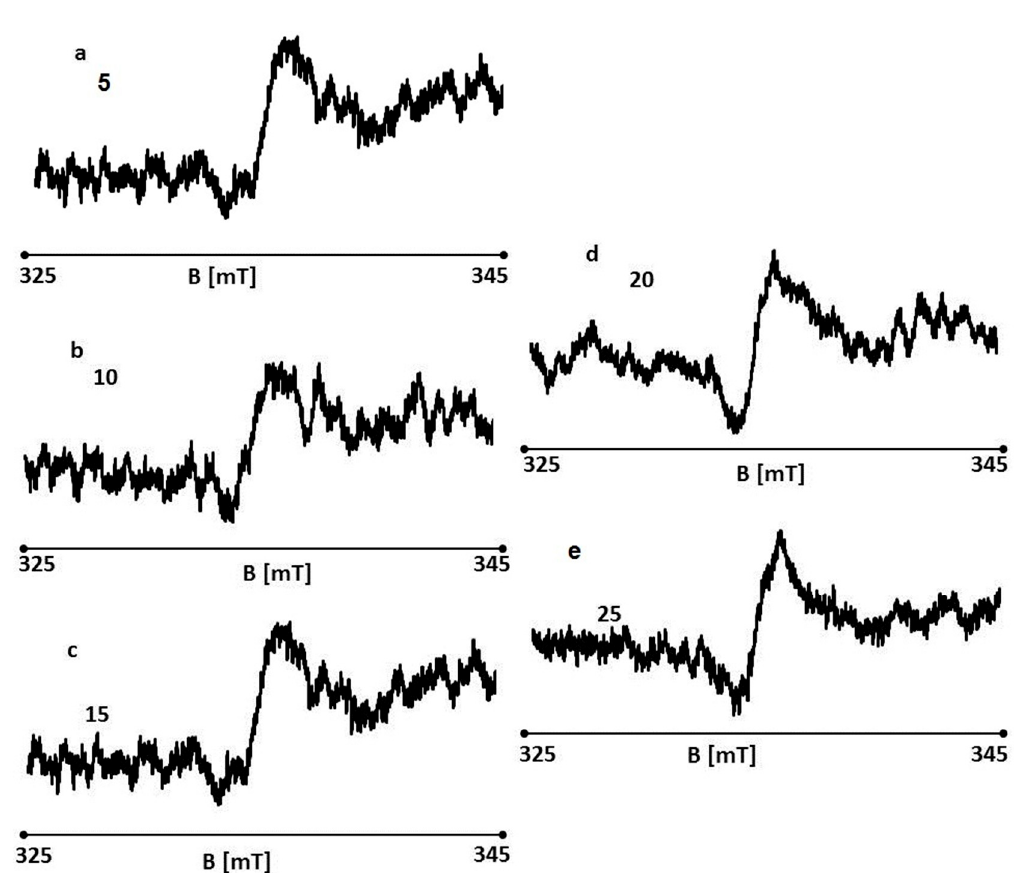
Figure 32. EPR spectra of sulfathiazole burn wounds on days 5 ( a ), 10 ( b ), 15 ( c ), 20 ( d ), and 25 ( e ) of the treatment.